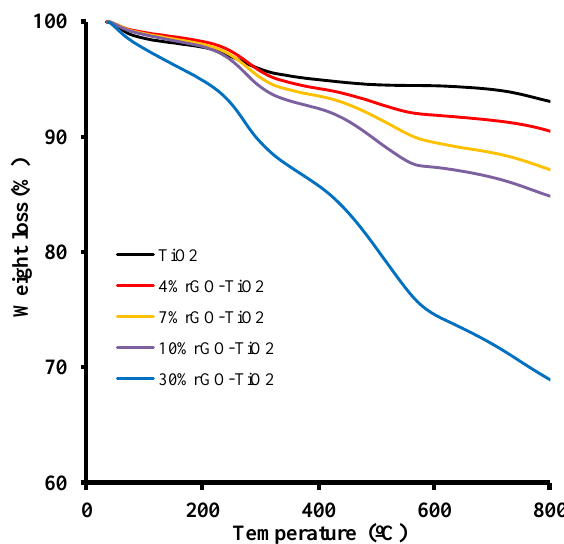
2 and x% rGO-TiO 2 .